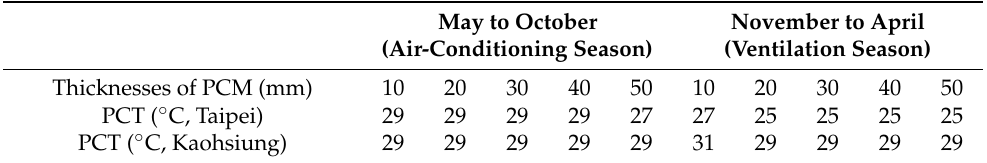
Table 3. Feasible PCTs under different PCM layer thicknesses.